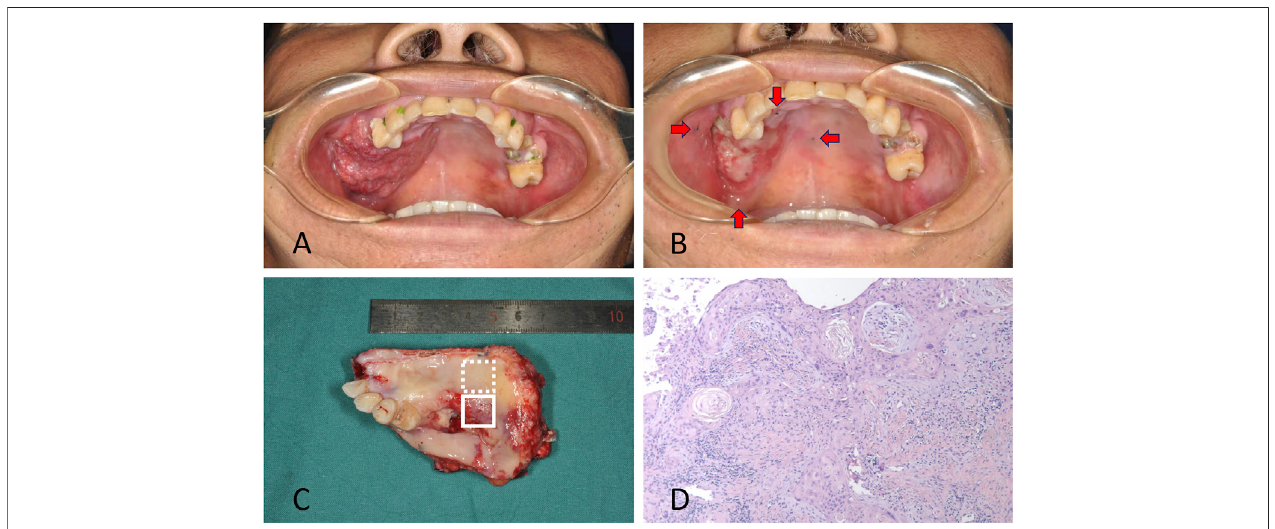
FIGURE1| (A) The patient withsquamous cell carcinoma located in gingivaofright maxilla. Theprimary lesion at the initialclinical evaluation before chemotherapy was shown. (B) The lesion after induction chemotherapy with a partial release. The marks showing the edges of the primary lesion made before chemotherapy were demonstrated by red arrows. (C) The resected tissue included the residual tumor (solid line box) and tumor bed (dotted line box). (D) Pathologic exam con fi rmed the residual tumor cells in the tissue.